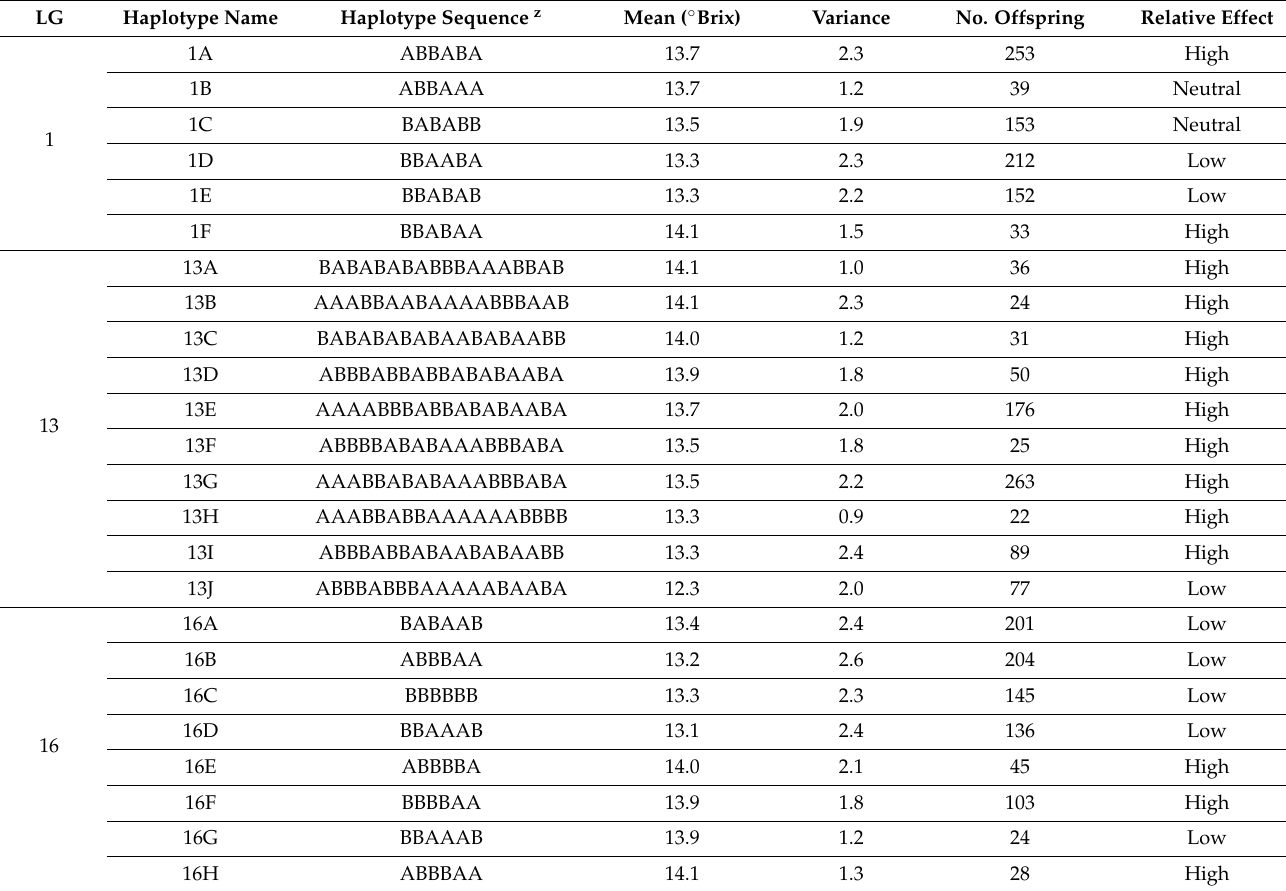
Table 3. Summary of QTL haplotype effects for the LG1, LG13, and LG16 SSC QTLs. Across-year adjusted SSC means for six families were